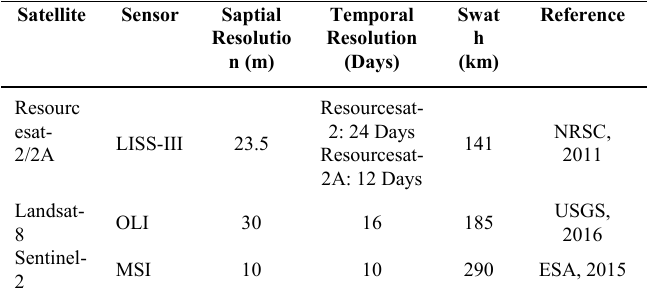
Table 1. Characteristics of remote sensing